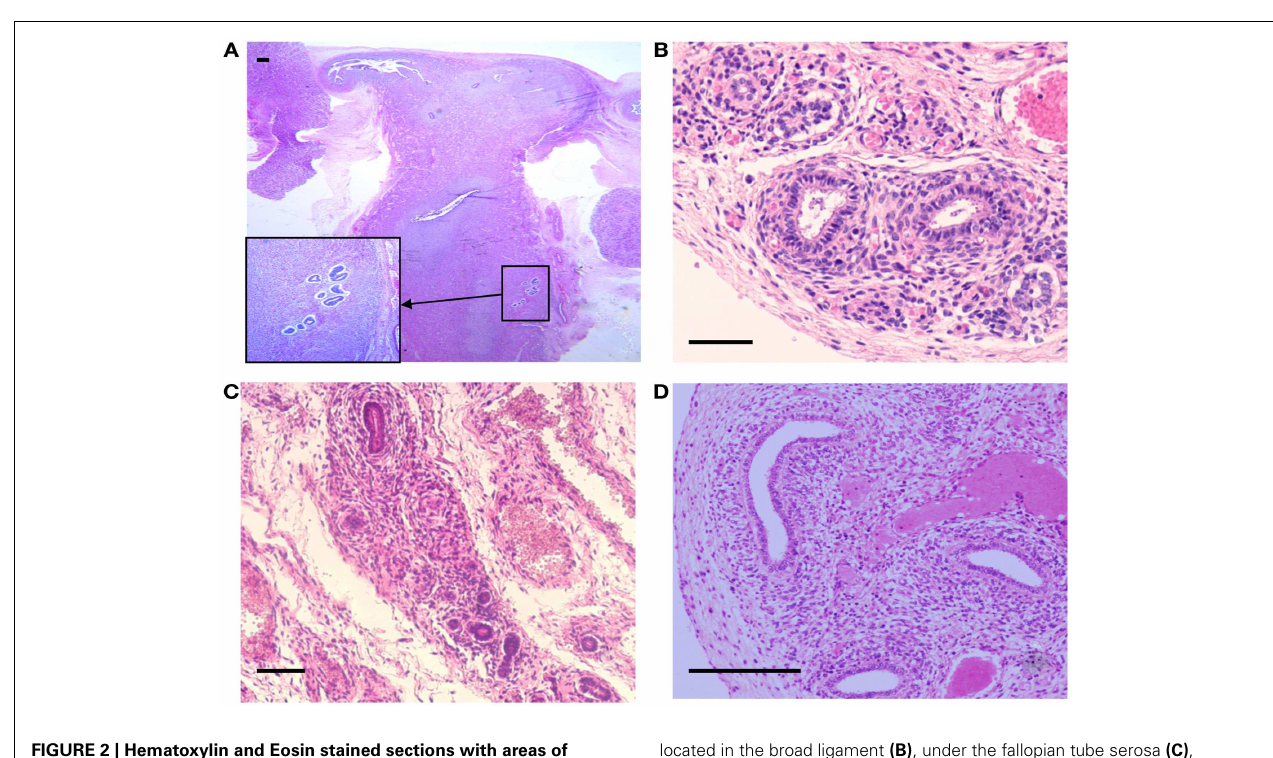
FIGURE 2 | Hematoxylin and Eosin stained sections with areas of ectopic endometrial glands and embryonic ducts. Histological appearance of ectopic glands and stroma observed (insert at higher magnification) in fetal uterine wall (A) . Presence of embryonic ducts